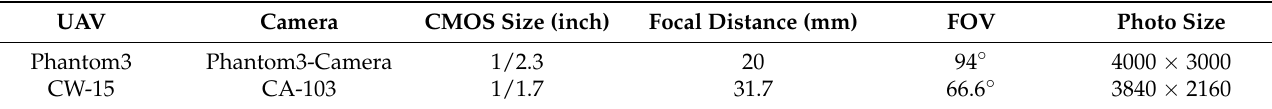
Table 1. Detailed description of the UAVs and sensors parameters used to acquire data. UAV Camera